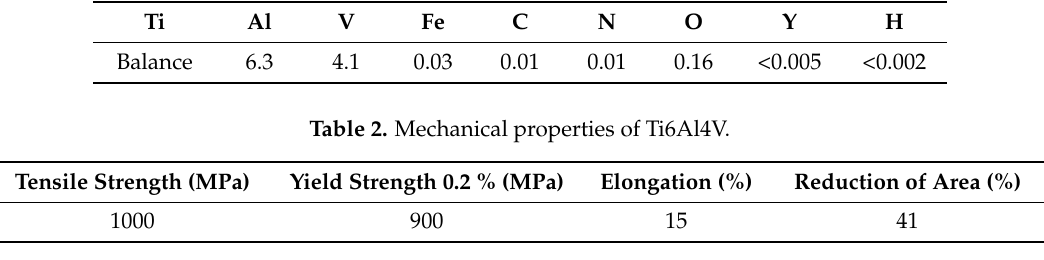
Table 1. Chemical composition of Ti6Al4V (wt. %).